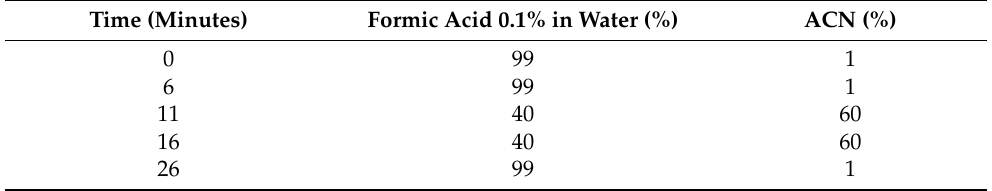
Table 1. Composition and gradient of the mobile phase required for P2Et estimation using HPLC. Time (Minutes) Formic Acid 0.1% in Water (%) ACN